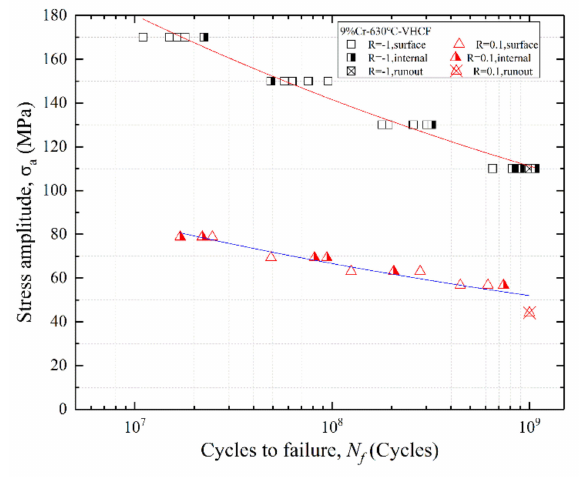
Figure 7. The S–N curves of 9%Cr turbine steel at R = − 1 and 0.1 under 630 ◦ C.